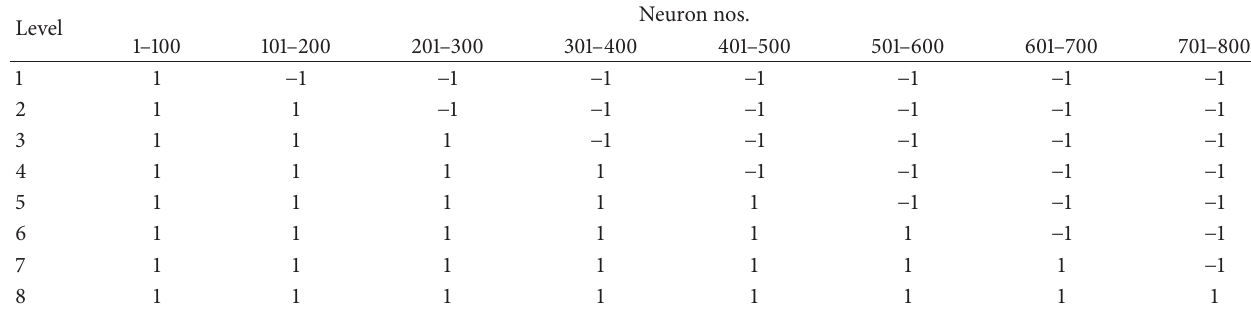
Table 6: Output status of the neural network.